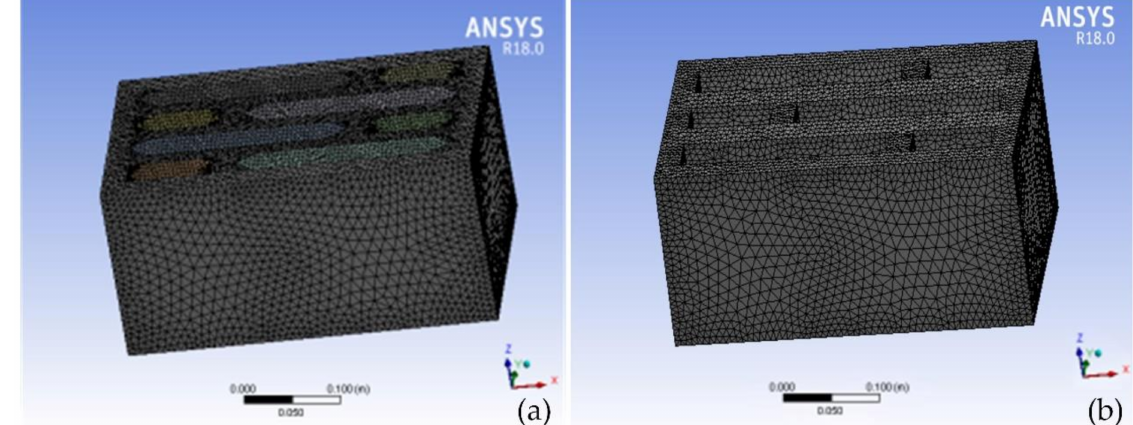
Figure 3. ( a ) Mesh model for the thermal analysis; ( b ) mesh model for the mechanical